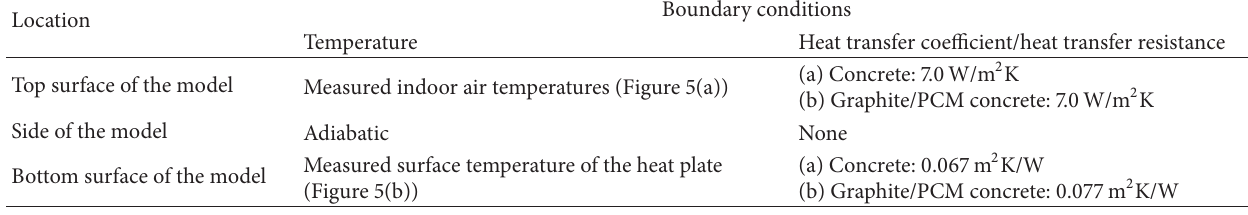
Table 2: Temperature and heat transfer coefficient boundary conditions of the simulation.